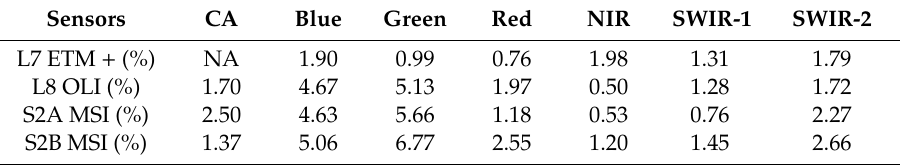
Table 11. Accuracy between measured and Niger 1 simulated